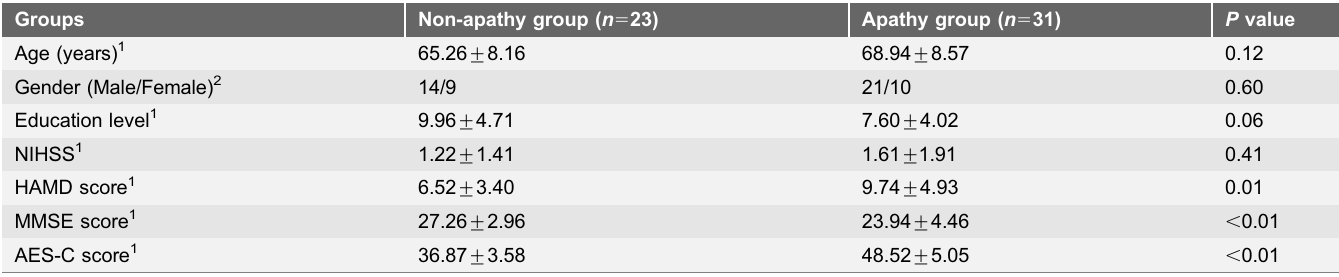
Table 1. Comparison of clinical data between groups.